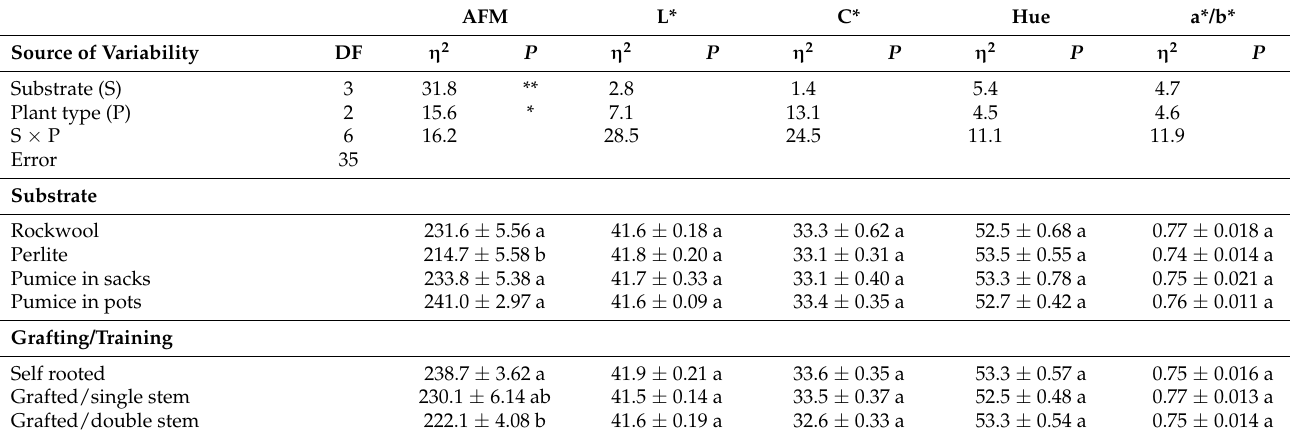
Table 4. Analysis of variance for average visual quality traits (fruit mass: AFM, luminance: L*, chroma: C*, hue, a*/b*) of tomato fruit harvested on 6 June. The fruit was obtained from self-rooted ‘Beef Bang F1’, ‘Beef Bang F1 grafted onto ‘Defensor’, trained in single or double stem and grown hydroponically in four substrates (rockwool slabs, perlite in sacks, pumice in sacks and pumice in pots) in a glasshouse.